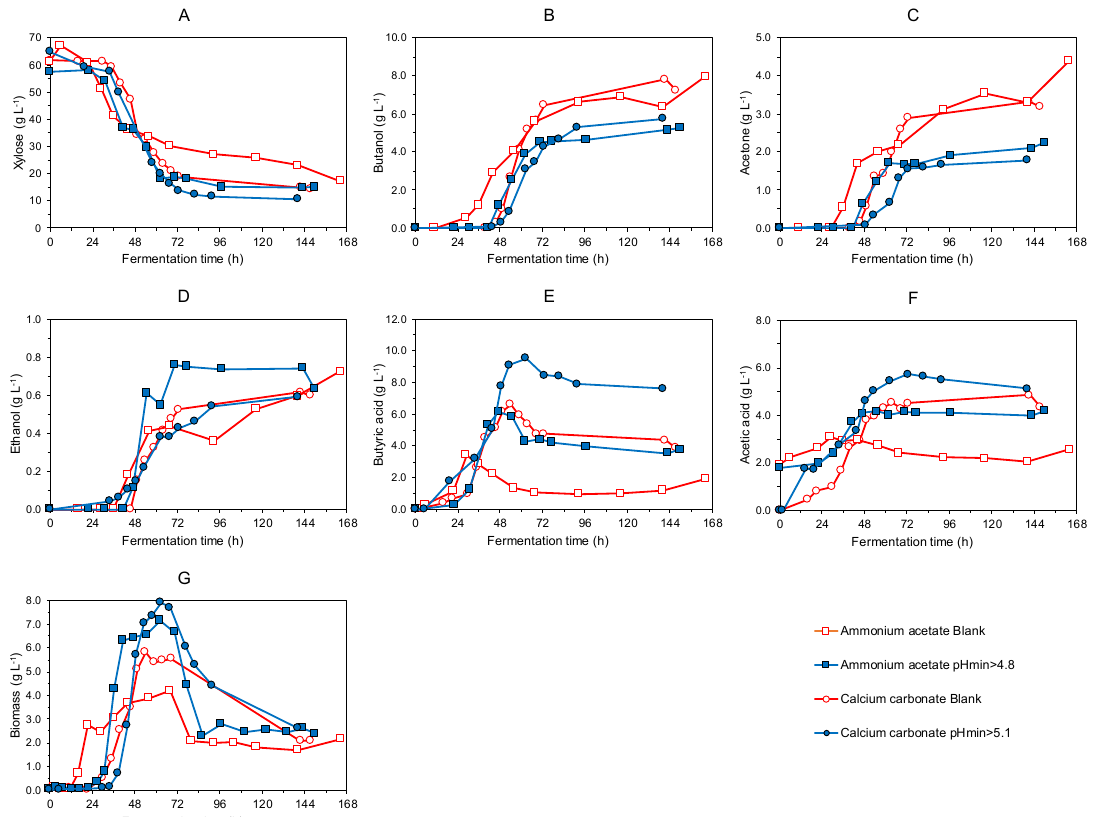
Figure 2. Fermentation profiles of ( A ) xylose, ( B ) butanol, ( C ) acetone, ( D ) ethanol, ( E ) butyric acid, ( F ) acetic acid and ( G ) biomass in g L − 1 with C. acetobutylicum with pure xylose in batch mode. Based on the xylose results, fermentation with mixtures of glucose/xylose (final monosaccharide concentration: 60 g L − 1 ) were developed for two sugar compositions. A 1:1 sugar ratio was first used (Figure 3). The pH evolution can be found in Figure S1B. Biomass concentrations were about 60% lower than those obtained with pure xylose, resulting in values of 2.5–3.2 g L − 1 , attributed to the lower biomass yield linked to glucose consumption. Capilla et al. [17] estimated a maximum biomass concentration of about 3 g L − 1 with 33 g L − 1 of pure glucose. The case of using calcium carbonate and a pH control strat ‐